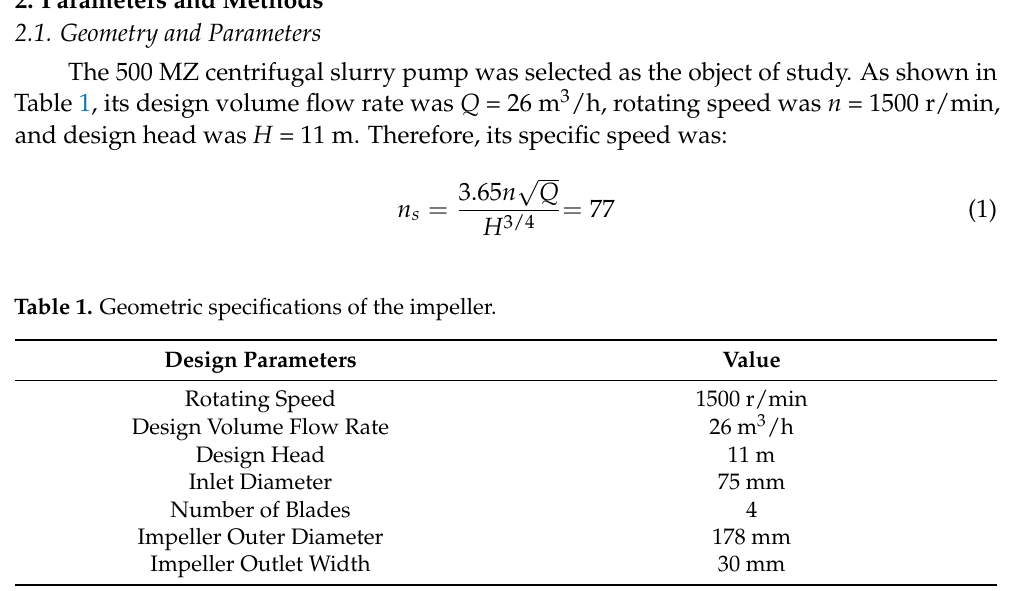
Table 1. Geometric specifications of the impeller.